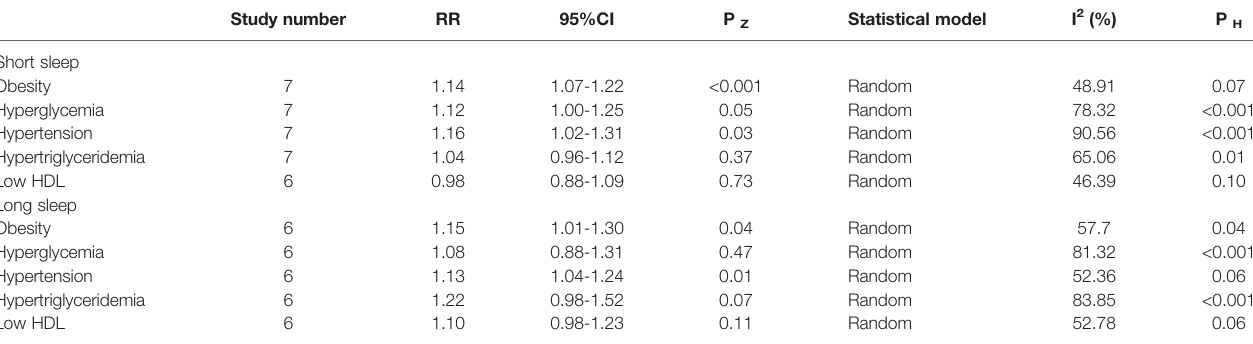
TABLE 2 | Meta-analysis of the associations between sleep duration and the components of